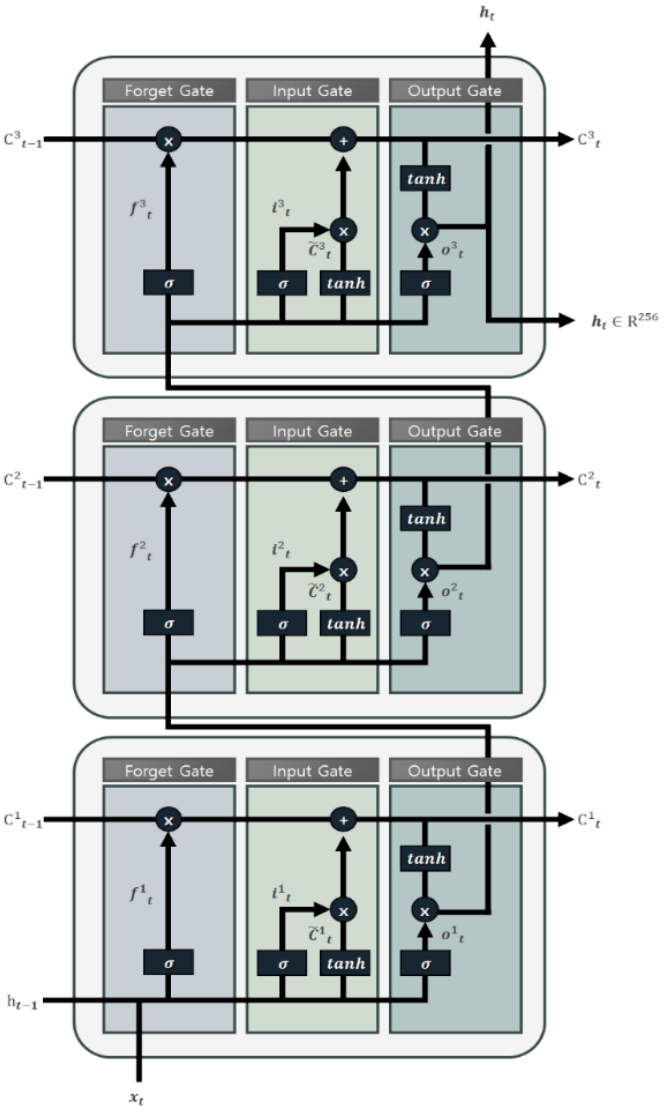
Figure 6. LSTM configuration.